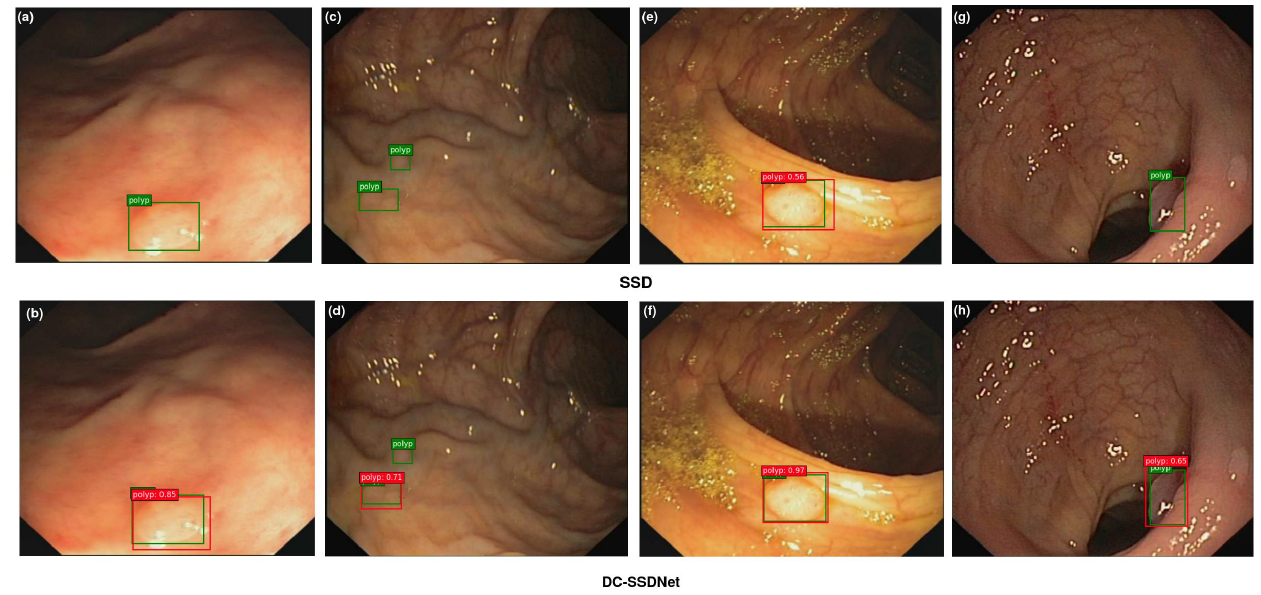
Figure 10. On the CVC-ClinicDB test set, visualization results comparing SSD300 ( a , c , e , g ) and the proposed DC-SSDNet network ( b , d , f , h ). True bounding boxes with IoU of 0.5 or greater are drawn in green, whereas predicted bounding boxes are in